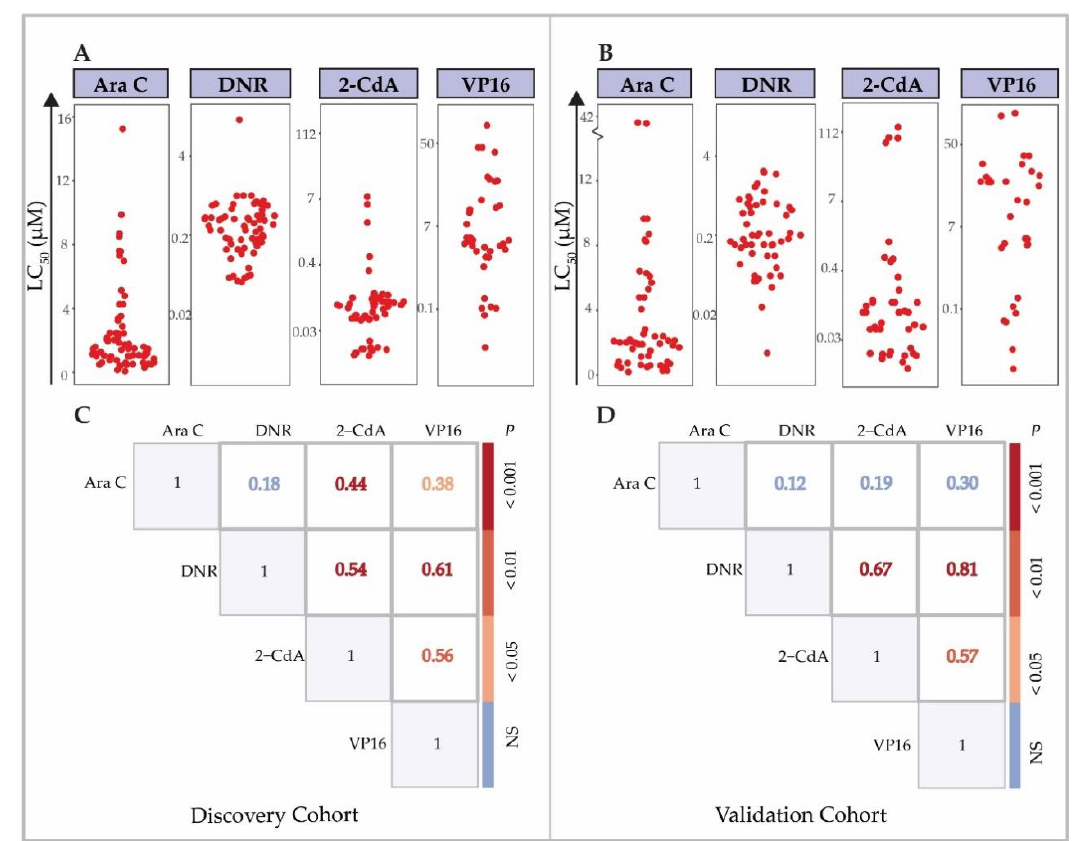
Figure 2. Distribution of ex vivo drug response data (LC 50 ) for chemotherapeutic drugs and cross-resistance. ex vivo drug response of primary AML cells to: Ara C, DNR, 2-CdA and VP16. Data are depicted as LC 50 values, the drug concentration (µM) at which 50% of the cells in the assay die. Each dot represents the LC 50 value of an individual sample. ( A ) Ex vivo drug response in discovery and ( B ) independent validation cohort. Cross-resistance between the tested drugs in ( C ) the discovery cohort and ( D ) validation cohort. Numbers represent the Spearman’s correlation coefficient of LC 50 values between shown drugs. p -value is calculated likewise and depicted according to the indicated color scheme.